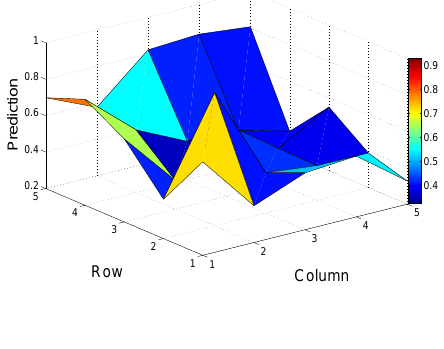
Fig. 16. The final optimal path for the experiment 2.